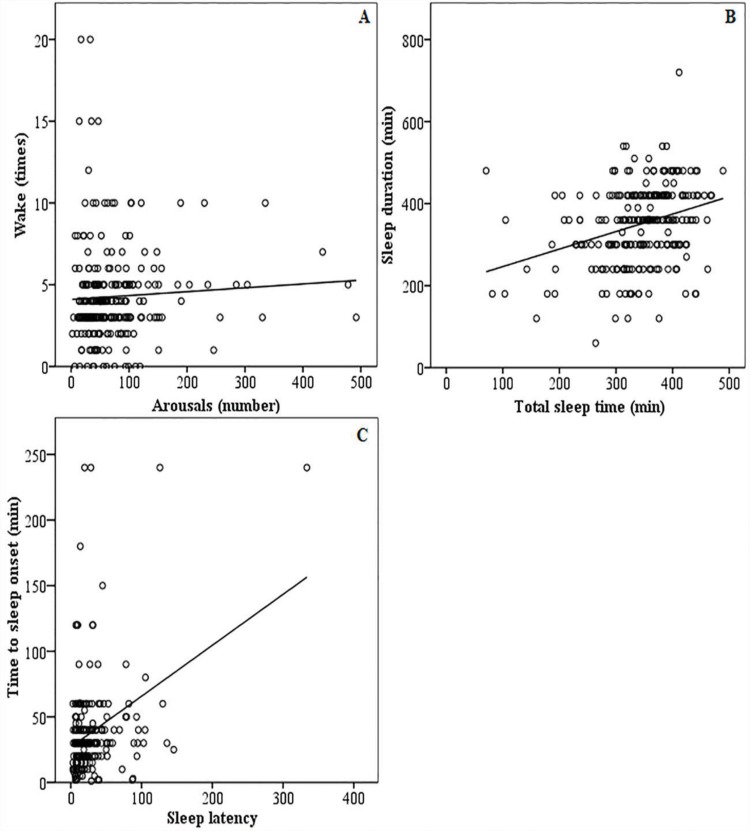
(A, B, and C). Dispersion curves comparing the self-reported (y-axis) and polysomnographic (x-axis) measurements of the 248 participants using Spearman's correlation. The straight line demonstrates a perfect correlation between the subjective and objective measures. Figure 2A shows the number of awakenings perceived in relation to arousals. Figure 2B shows the correlation between the perceived sleep time and the total sleep time (TTS). Figure 2C shows the discrepancy between the time perceived for the beginning of sleep and the sleep latency.